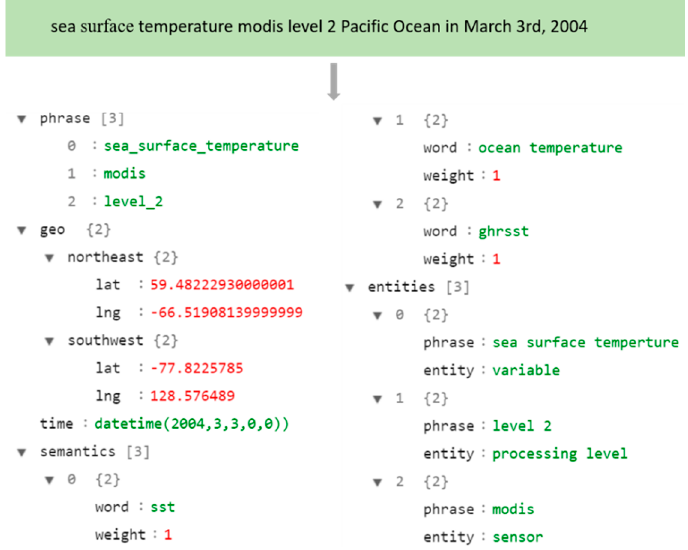
Figure 8. Query understanding result of a sample query.